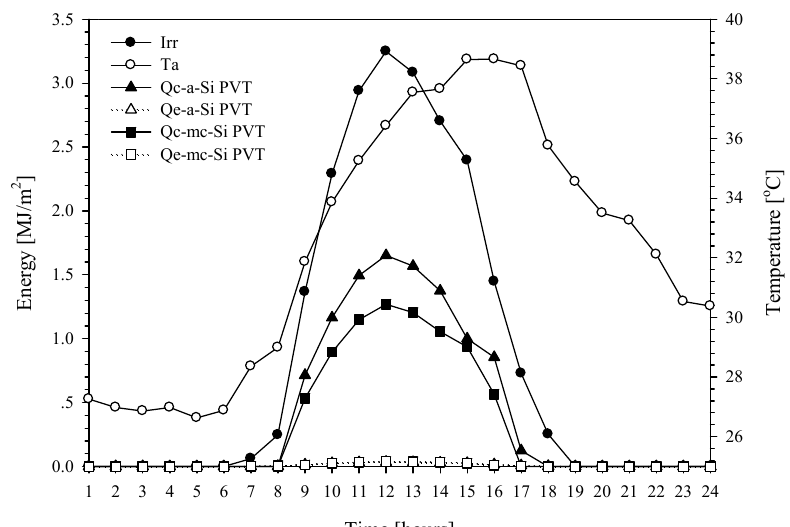
Figure 8. Daily energy production of PVT